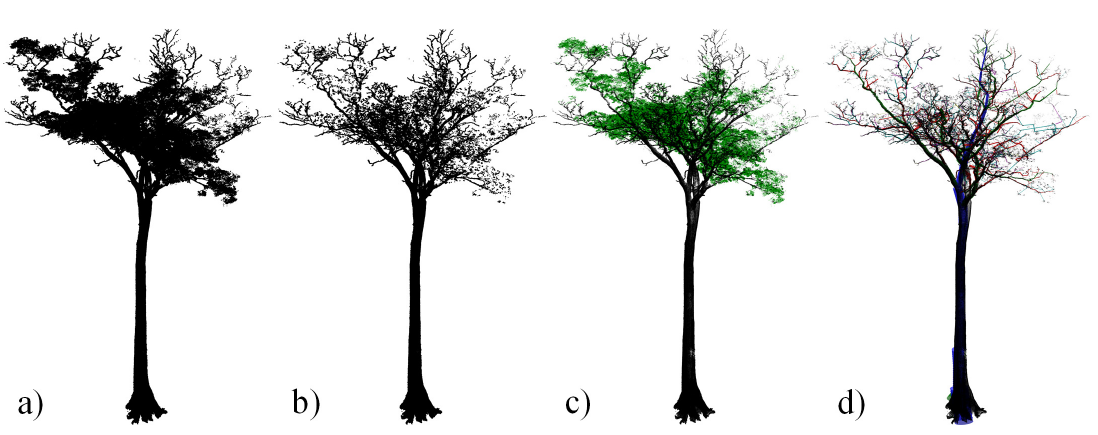
Figure 2. ( a ) Vitex spp. tree point cloud (TLS-derived H = 51.8m and TLS-derived D = 114.6cm with POM at 5.3m), ( b ) down-sampled tree point cloud (0.026m point spacing, as in Calders et al. [42]), ( c ) soft tissues (green) and hardwood (black) separated point cloud [43], and ( d ) TreeQSM modelled after the hardwood point cloud.